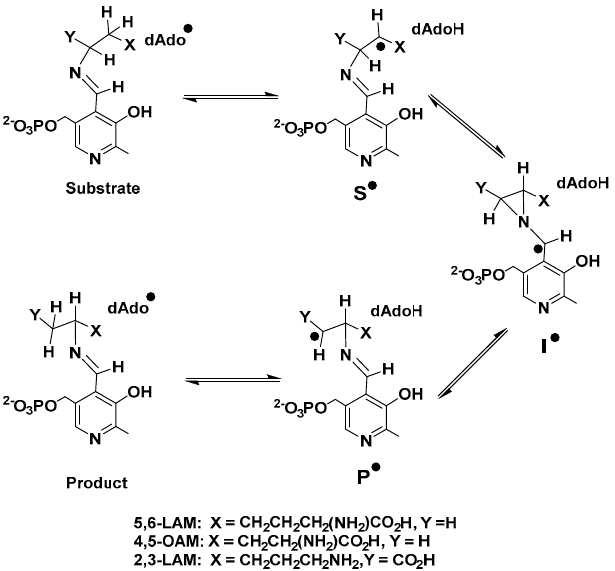
Scheme 1. Proposed reaction mechanism of radical